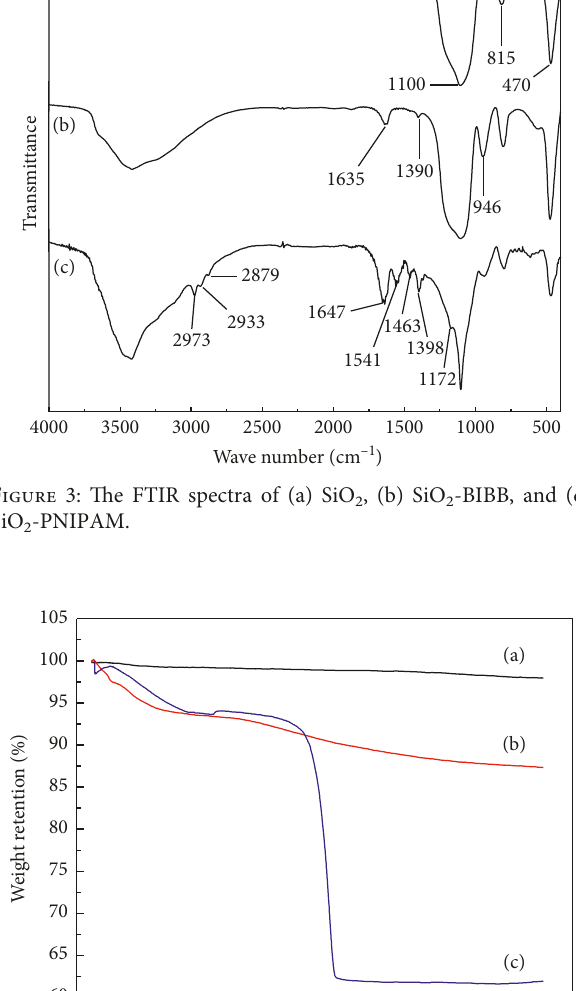
2 , (b) SiO 2 -BIBB, and (c) SiO 2 -